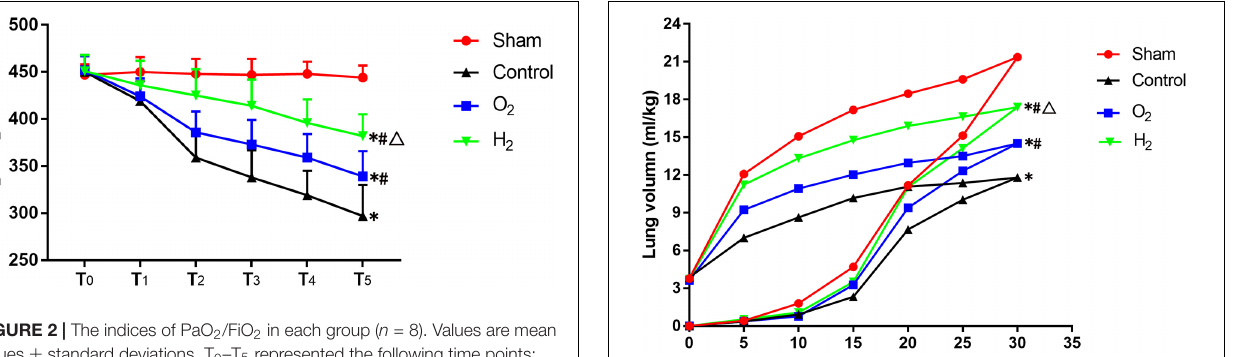
control group ( P < 0.05). The P-V curve values of the H 2 ( P < 0.05) ( Figure 3 ).